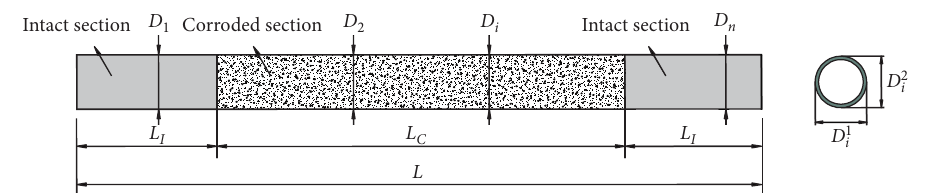
Figure 6: Demonstration of section categorization and